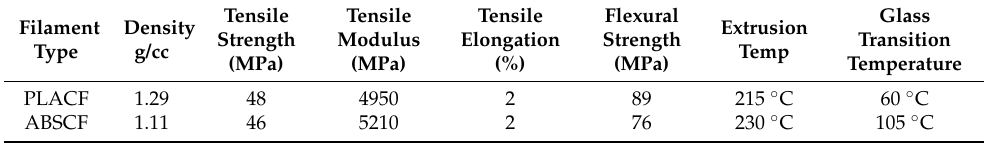
Table 1. Properties of polymer ABSCF and